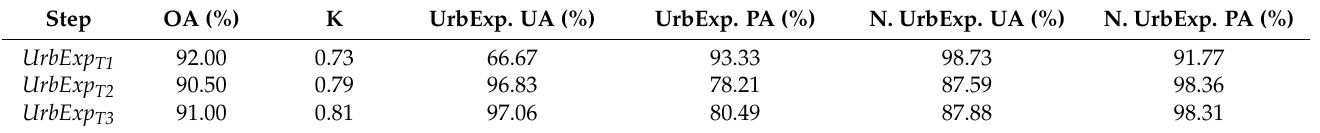
Table 3. Accuracy assessment of urban expansion maps at each time step ( UrbExp T1 , UrbExp T2 , UrbExp T3